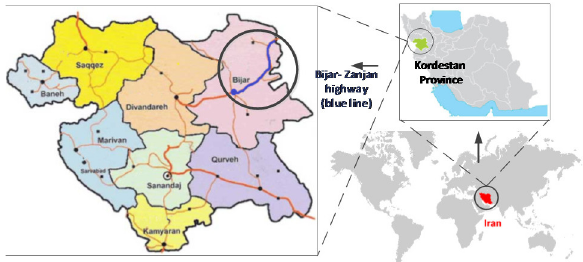
Fig. 3. Layout of the case study (Bijar-Zanjan highway construction project)